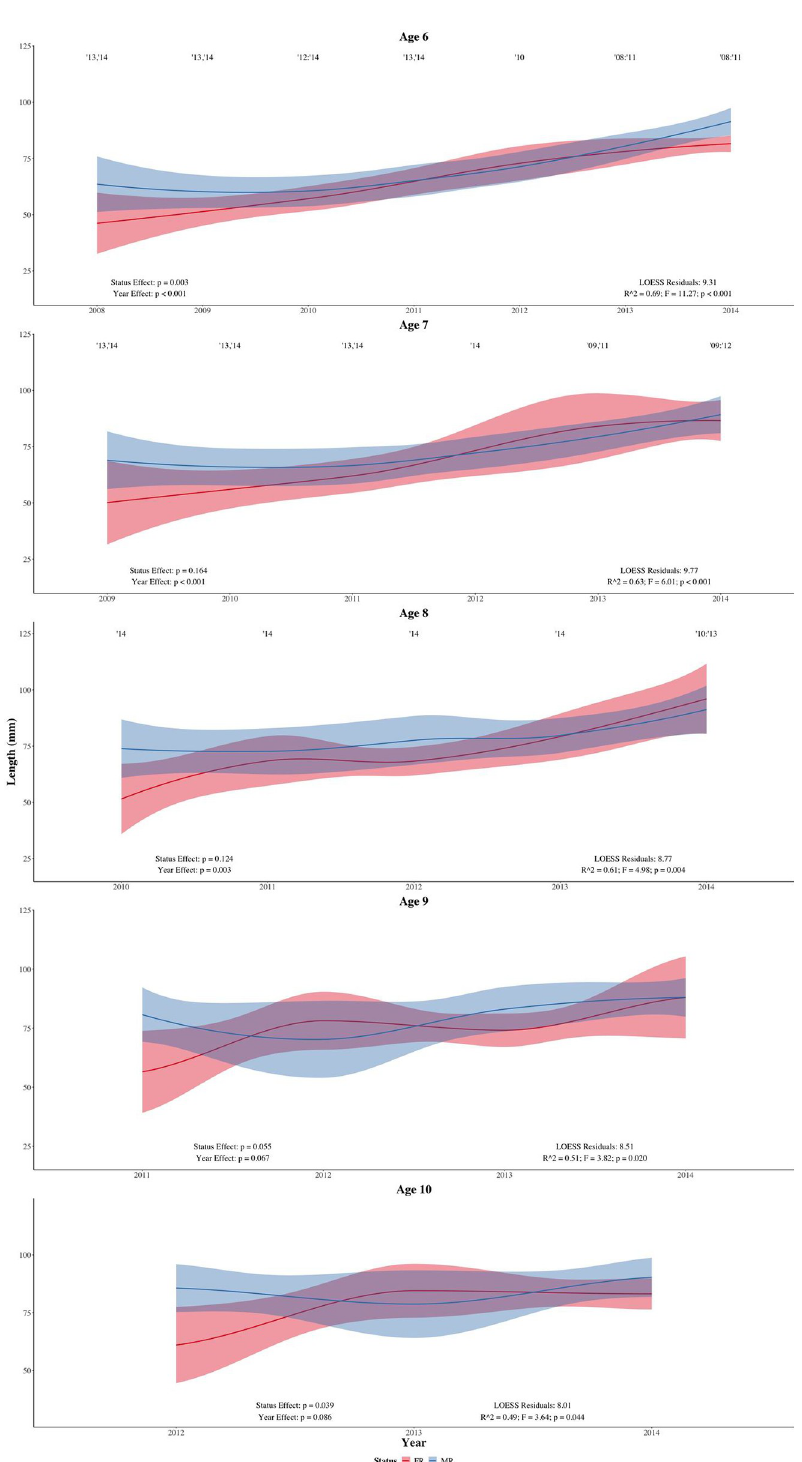
Fig 4. LOESS regressions for age cohorts six to ten. Two-way ANOVA results are shown in the lower left corner of each age plot, with significant disparities between year classes (year effects) indicated via year numbers above the regressions of each age